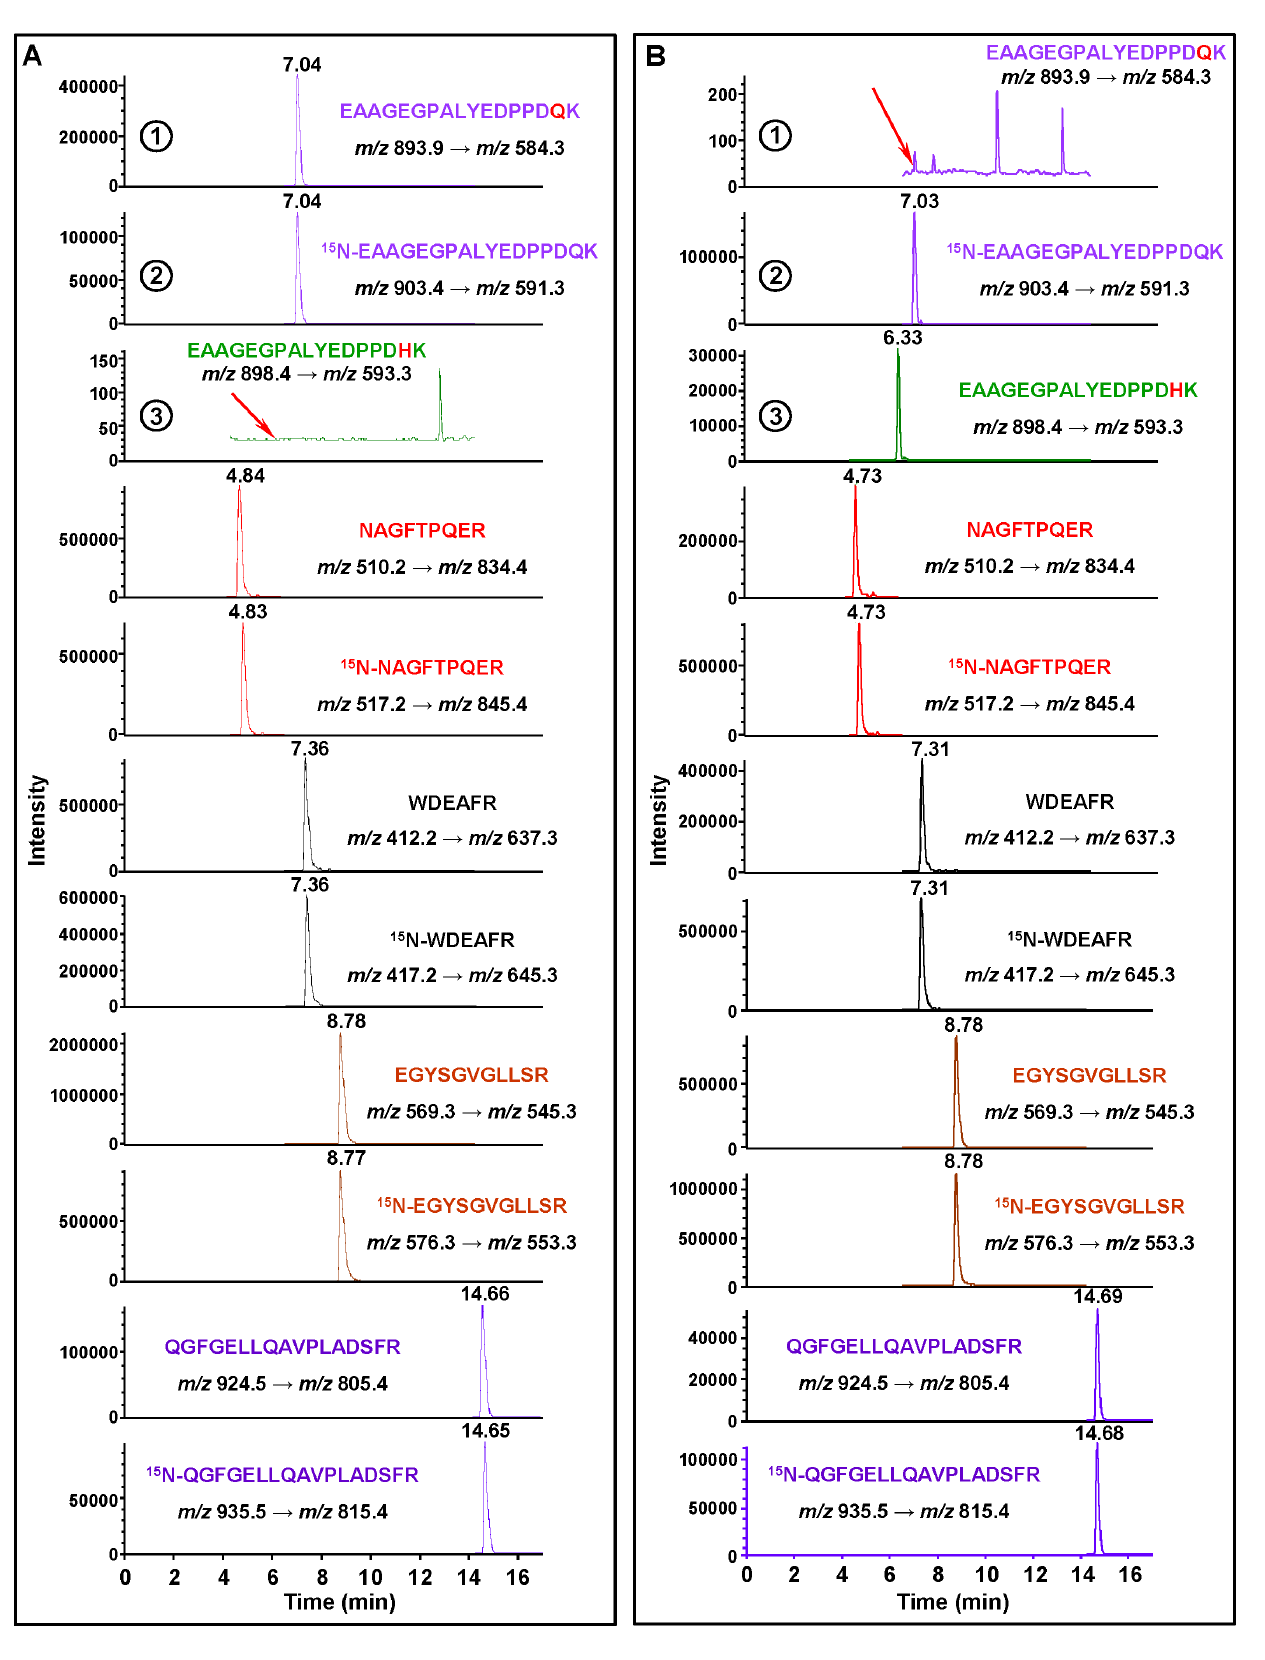
Figure 8. Detection of the Gln51His variant of hAPE1. A: wild type hAPE1, B: Gln51His variant. Ion-current profiles of the mass transitions of EAAGEGPALYEDPPD Q K of wild type hAPE1 ( 1 ), 15 N-EAAGEGPALYEDPPDQK of 15 N-hAPE1 (the internal standard) ( 2 ) and EAAGEGPALYEDPPD H K of